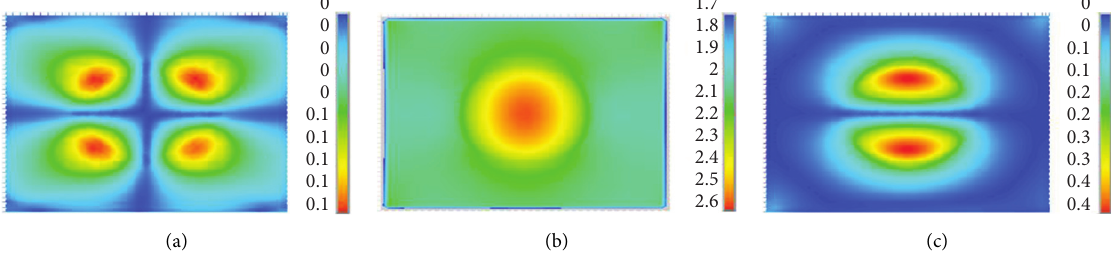
� 500m/s). Top view displacement cloud view (a) u s